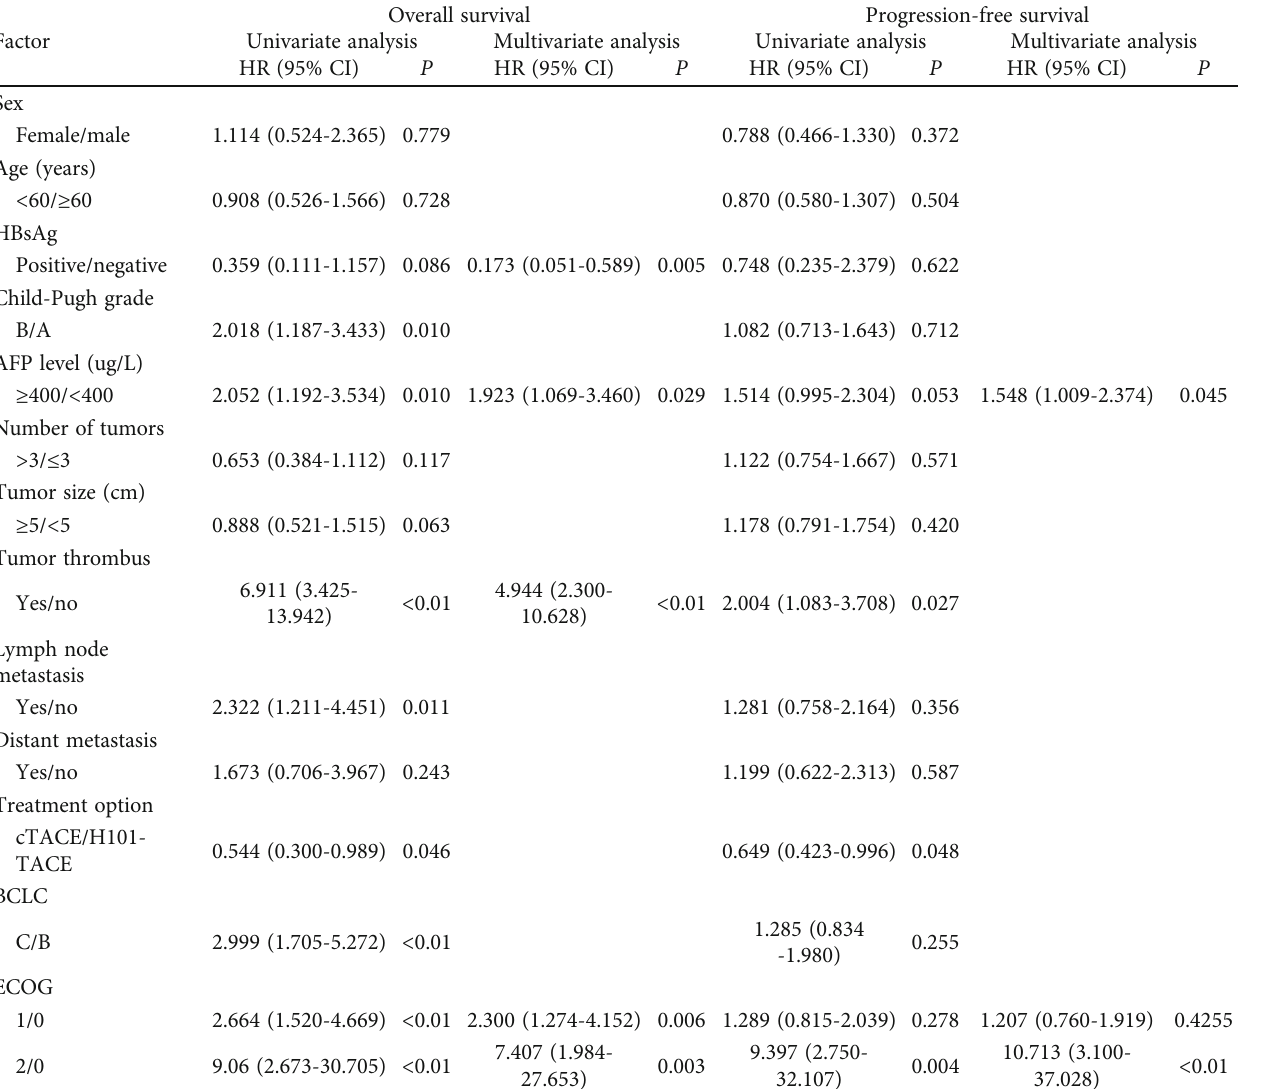
Table 3: Survival prognosis-linked factor assessments.